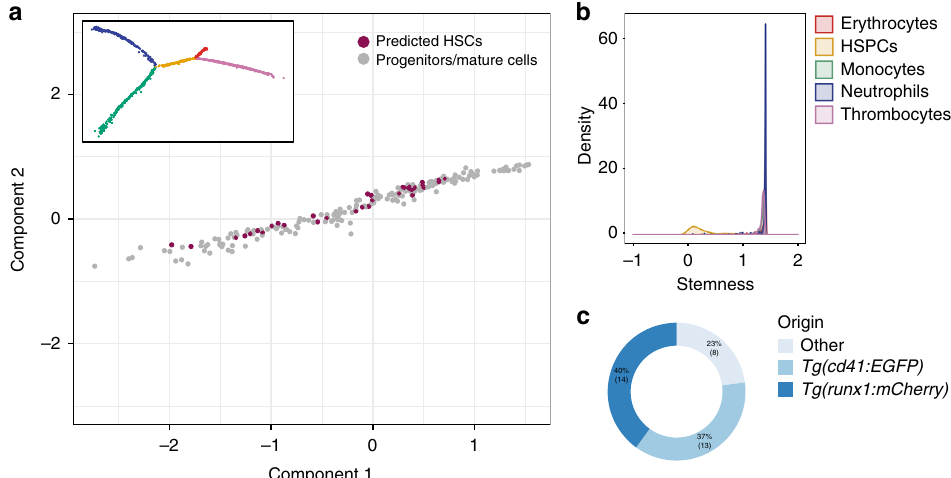
Fig. 4 Transcriptionally similar cells display different probabilities of being stem cells. a Cells predicted to be stem cells in the middle part of the lineage tree according to their stemness index. The insert shows the new Monocle tree including transplanted cells (1724 single cells and 1871 highly variable genes). b Distribution of stemness scores in different branches of the tree showing the presence of potential HSCs exclusively in the HSPC branch. c Contribution of different transgenic lines to predicted stem